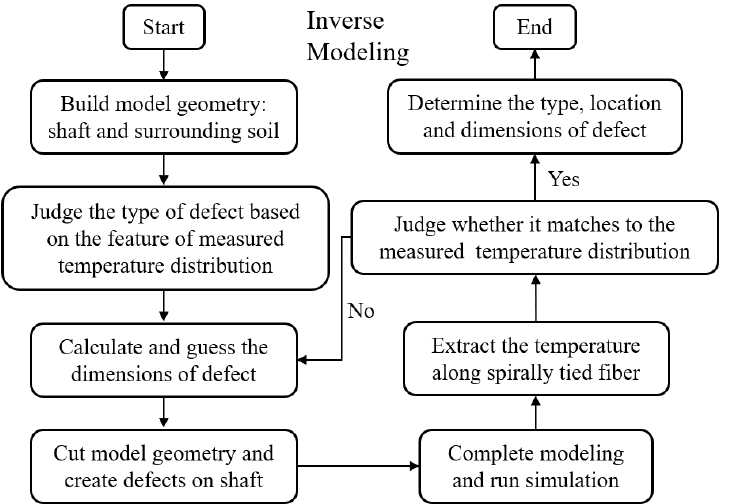
Figure 3. Simulation flowchart of the inverse modeling for fiber optic-based TIP with spiral de- ployment.